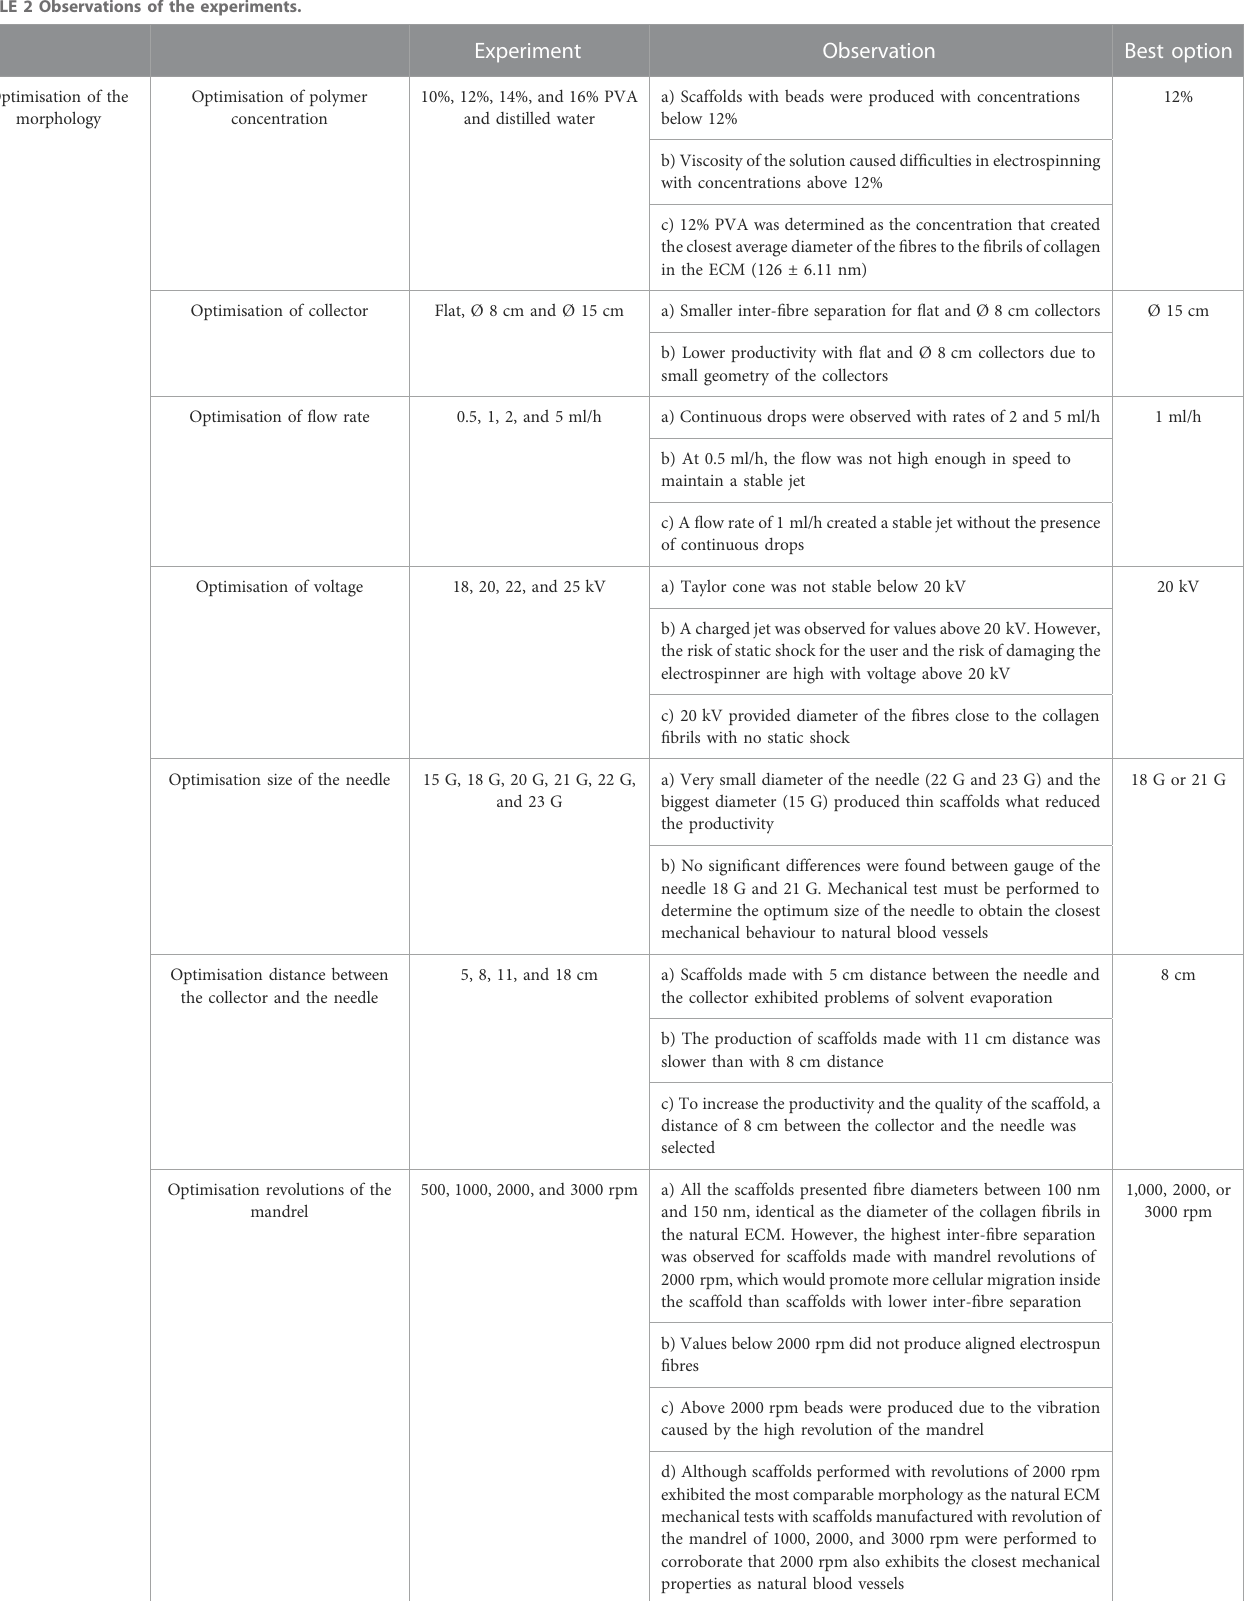
TABLE 2 Observations of the experiments. Experiment Observation Best